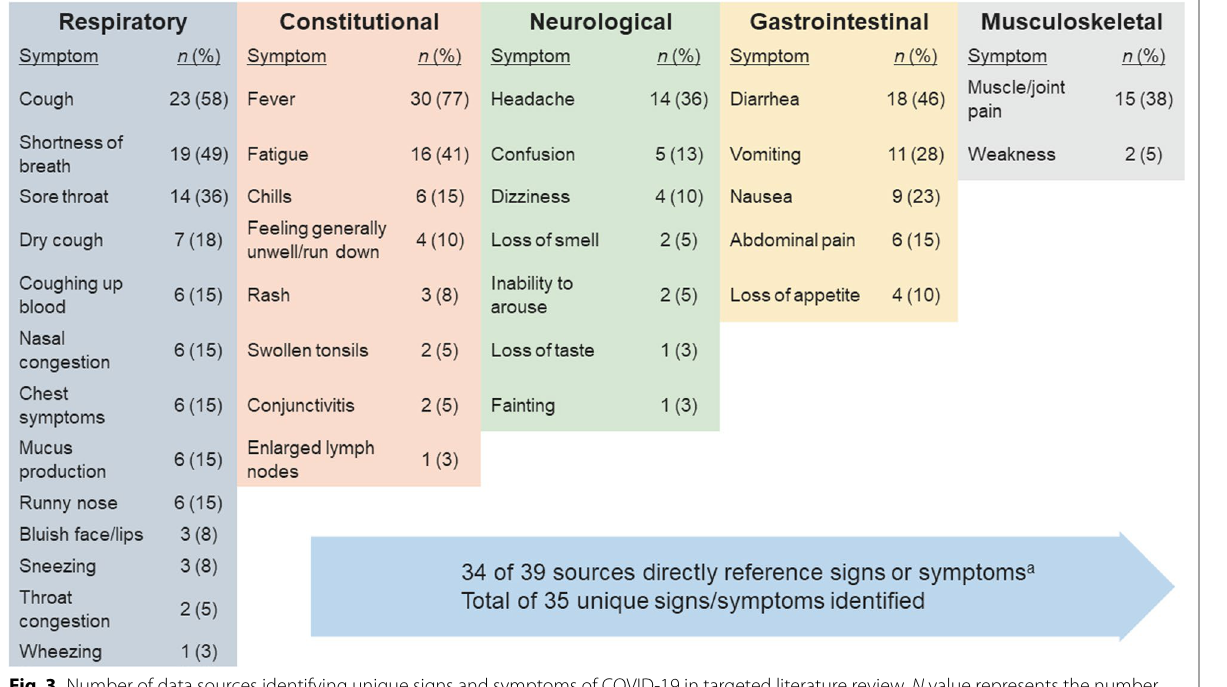
Fig. 3 Number of data sources identifying unique signs and symptoms of COVID-19 in targeted literature review. N value represents the number of references directly reporting each COVID-19 sign/symptom by body system. a Unique signs/symptoms identified. Abbreviation: